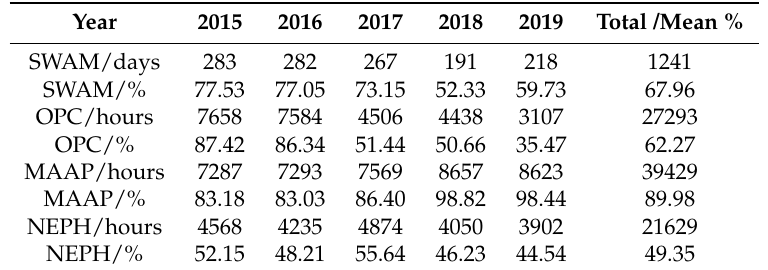
Table 4. Data availability for SWAM, OPC, MAAP and nephelometer for the (2015–2019) quality checked dataset.